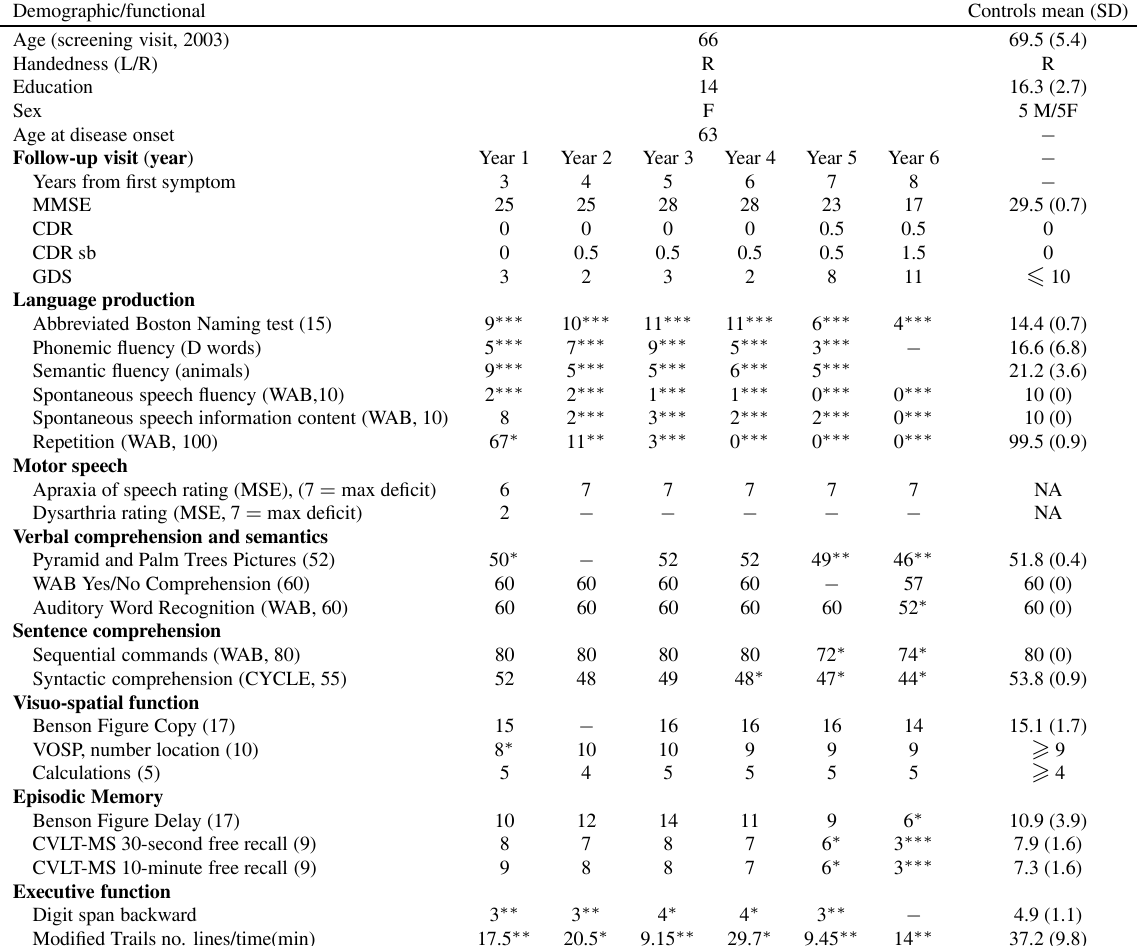
Table 2 Voxel-based morphometry of grey matter changes in FC, comparing each year’s scan against 17 female right-handed age-matched